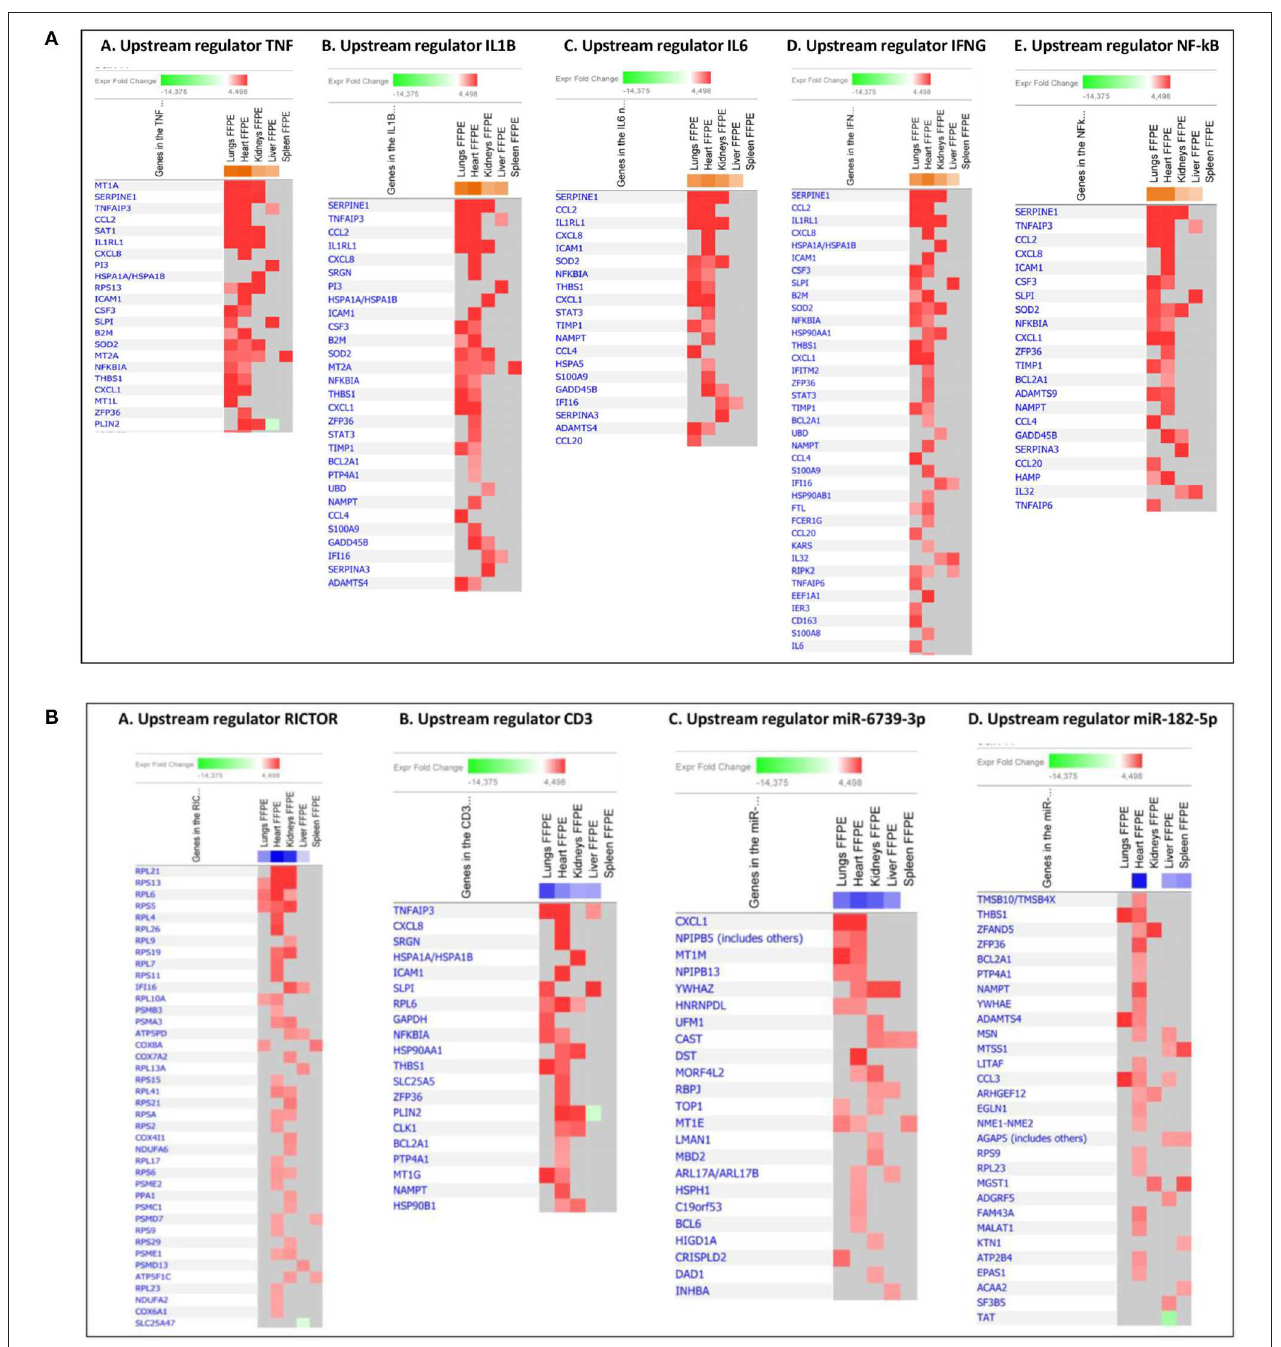
FIGURE 9 | Predicted gene signaling network from the top up-regulated (A) and down-regulated (B) upstream regulators in FFPE tissue samples from patients with meningococcal septic shock vs. controls. The Z-score indicates predicted activation state of genes in the upstream regulator signaling network. Orange or lighter shades of orange indicate a positive Z-score and up-regulation of the upstream regulator. Blue color or lighter shades of blue indicate a negative Z-score and down-regulation of the upstream regulator. The transcripts in the signaling network are expressed as Fold Change (FC) values. Red or lighter shades of red indicates positive FC-values and up-regulation of transcripts, green color or lighter shades of green indicates negative FC-values and down-regulation of transcripts. Color gray indicates that a predicted activation state of a gene/transcript in the upstream regulator signaling network is not affected. to be the principal cause of the acute renal failure. Patient 1,